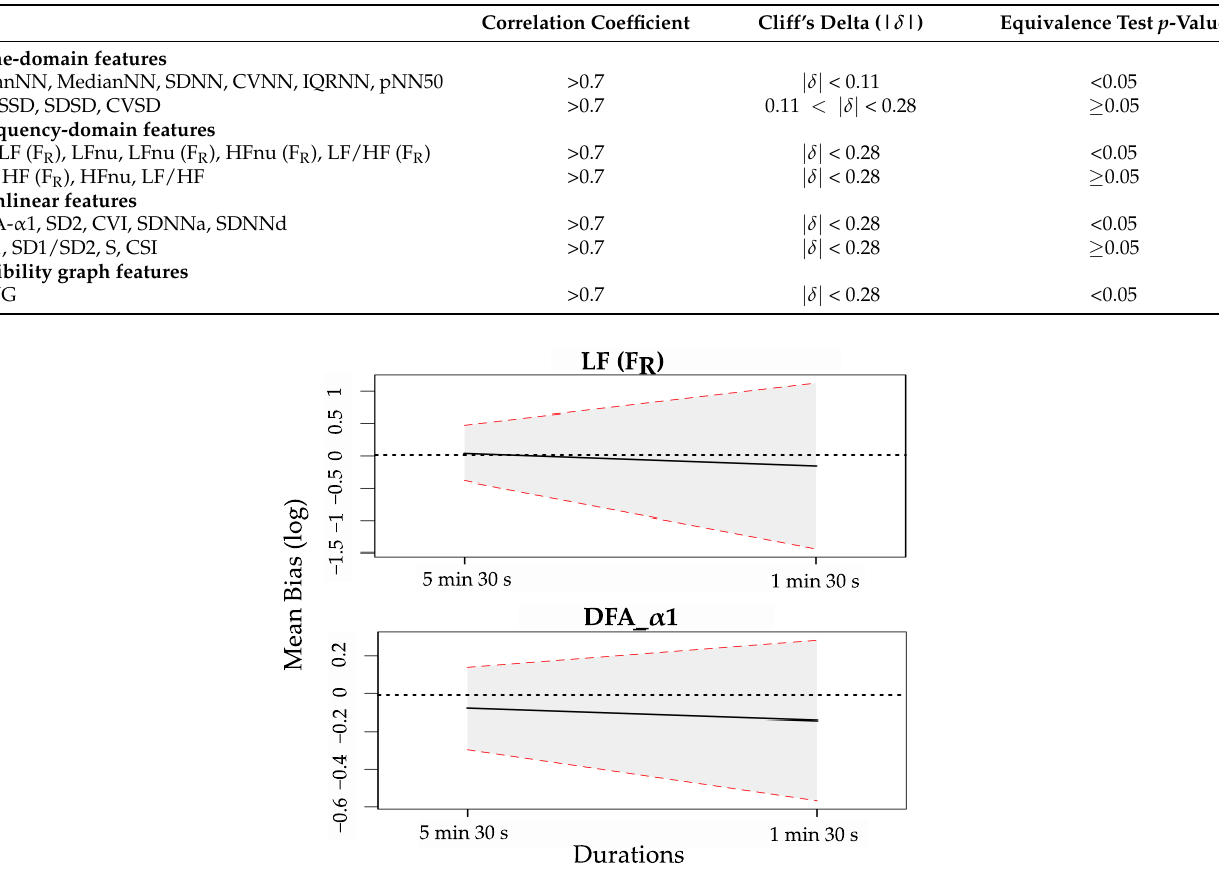
Table 1. Features showing good agreement between PPG 25 Hz (5 min 30 s) and ECG recordings.